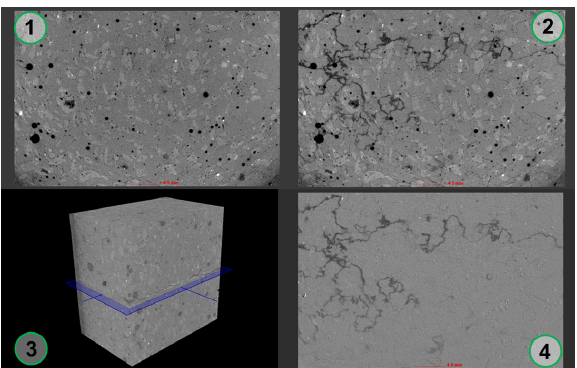
Figure 6. Visualization of tomographic cross-sections taken in the same place parallel to the direction of the crack propagation ( xy plane). 1) Visualization of the cross-section before three-point bending; 2) Visualization of the cross-section after three point bending; 3) Plane representing the position of the visualized cross-sections (orientation of the volume corresponds to Figure 3); 4) Differential image with highlighted differences (cracks).